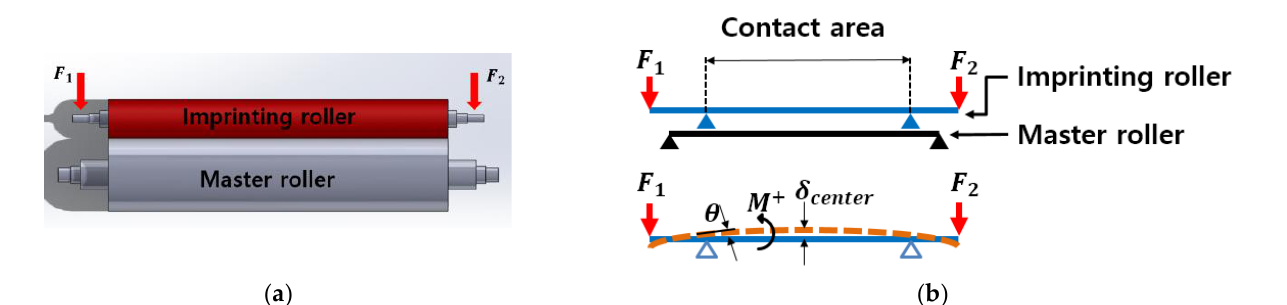
Figure 1. Conventional R2R NIL pressing process: ( a ) Imprinting module of conventional R2R NIL system; ( b ) Free body diagram of conventional R2R NIL pressing process.